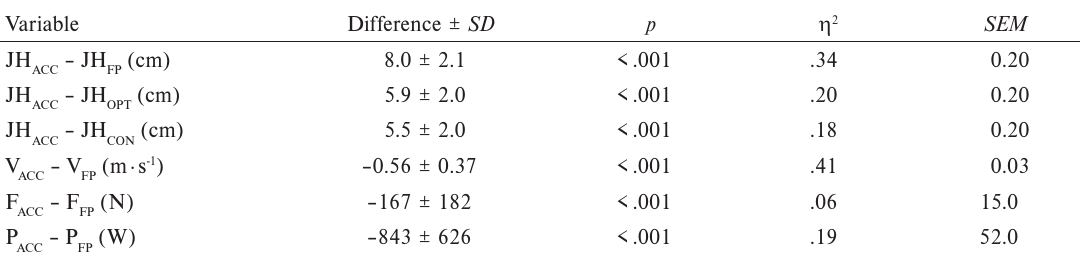
Systematic bias between methods for determining jump height (JH), peak velocity (V), peak force (F), and peak power (P) using a Myotest accelerometer (ACC), Optojump (OPT), JH from the force plate impulse (FP), and JH from force plate contact time (CON). Effect sizes ( η 2 ) and standard errors of the measurement (SEM) are also